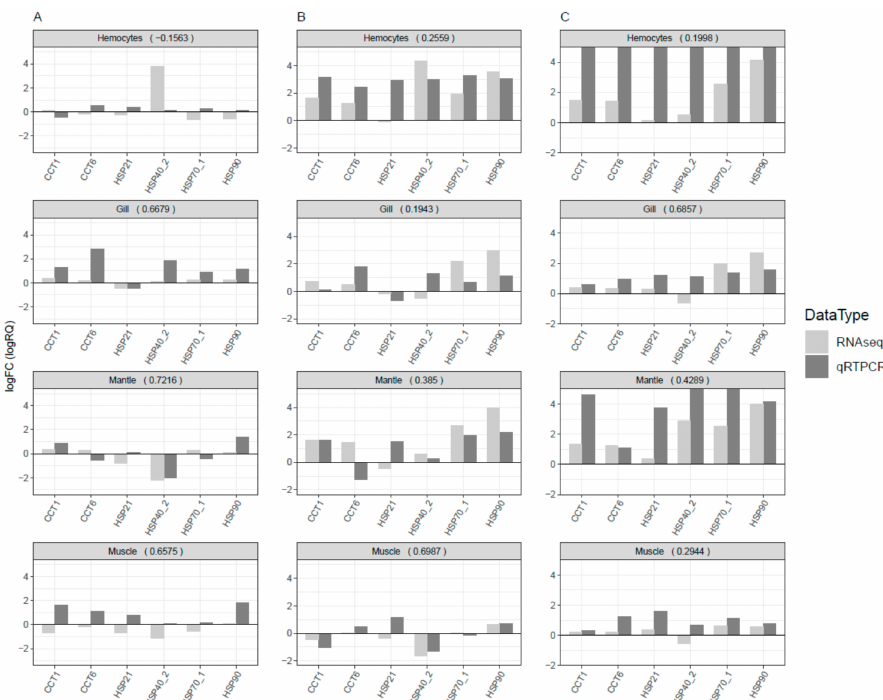
Figure 7. Systematically selected HSP genes for qRT-PCR validation to assess the reproducibility of the RNA-Seq expression profiles from di ff erent experimental replicates. The log fold change values from both experiments were compared and Pearson correlation coe ffi cients were calculated to assess the linear relationship between the experiments. The log fold change values for RNA-Seq were obtained from transcripts per million, and relative quantification values were used from qRT-PCR. Values > 5 were reduced to 5 to enhance the visibility of the bar chart and present a common scale for easy interpretation. ( A ) Optimal vs. cold; ( B ) optimal vs. thermal; and ( C ) thermal vs.